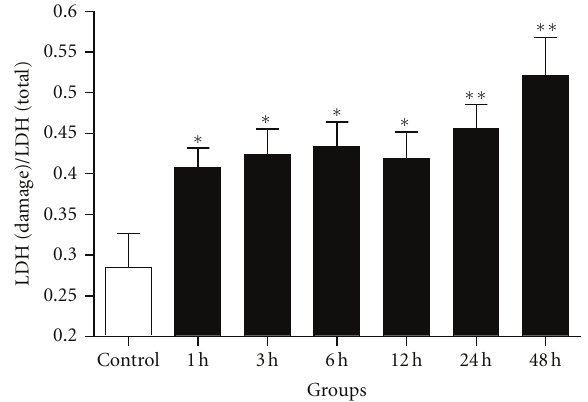
Figure 8: LDH leakage assay was performed for assessing neuron deaths. Cytotoxicity was induced by Hb. Neurons were incubated with 10 μ M Hb for 1, 3, 6, 12, 24, and 48h, respectively. Significant increasing in LDH leakage was found after Hb incubation, ∗ P < 0 . 05 and ∗∗ P < 0 . 01 versus control group. Bars represent the mean ± SEM ( n = 6, each